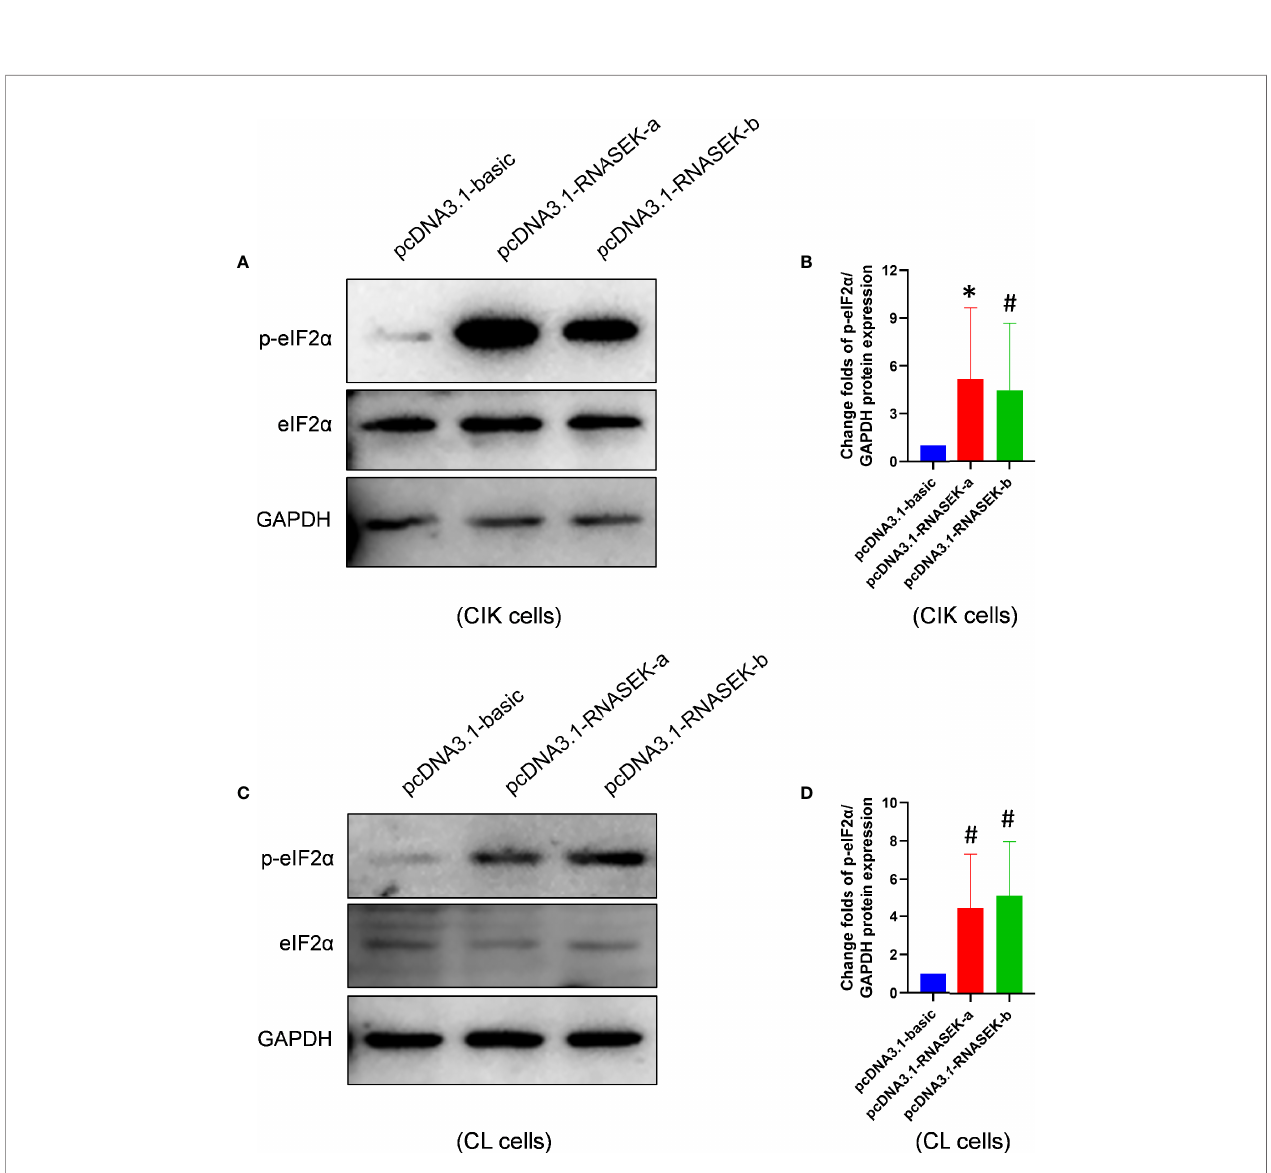
FIGURE 6 | Grass carp RNASEK-a and -b individually activate eIF2 a . (A, C) In CIK (A) and CL (C) cells, the protein levels of basal and p-eIF2 a were determined by Western blot with GAPDH as a loading control. (B, D) The grayscale values of p-eIF2 a bands representing (A, C) were separately calculated by the ImageJ software ( n = 3 – 5; the control data were normalized to 1). Cell type is marked in each image. Overexpression of RNASEK-a and -b was conducted by transfection of pcDNA3.1-RNASEK-a and -RNASEK-b into cells for 36 h, respectively. All values are mean ± SD. These results are representative of three independent experiments. * P < 0.05 (B) and # P < 0.10 (B, D) versus the pcDNA3.1-basic